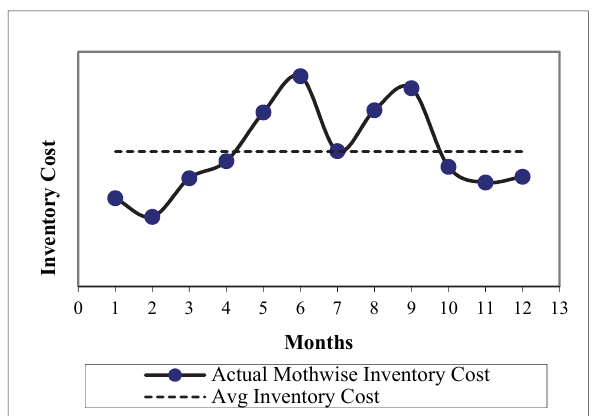
Fig. 3. Monthly variation of Total RWM Inventory Cost (Mallick et al., 2012)